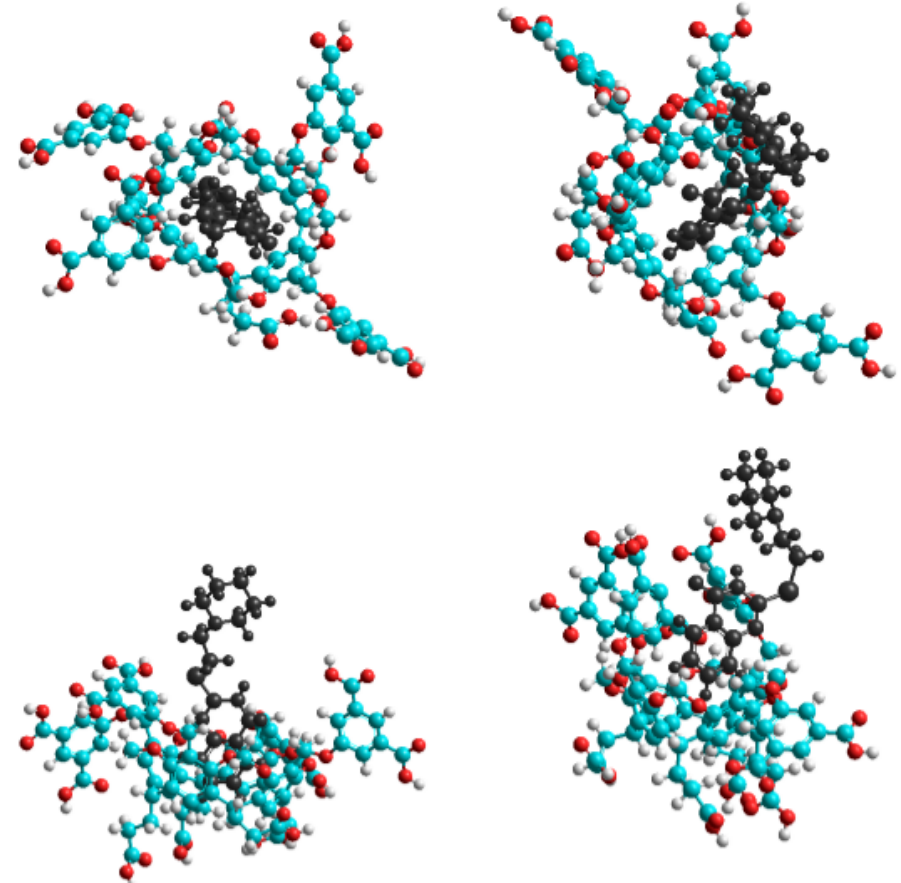
Figure 4. Top ( top ) and side ( bottom ) views of the equilibrium conformations of host–guest complexes of 1 with 6 . The guest 1 molecule enters into the cavitand cavity by its piperidine ( left ) or quinazoline moiety ( right ). Table 4. Thermodynamic parameters associated to the complex formation of 1 with 6 in methanol or the DMF solvent simulated by the TIP3P solvent